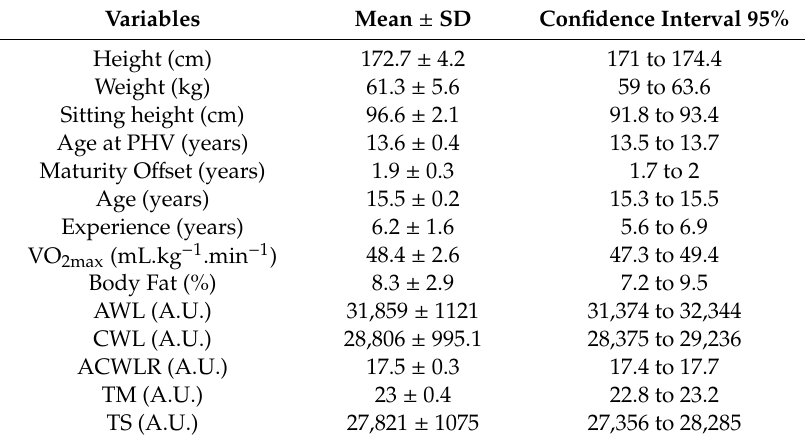
Table 1. Descriptive characteristics of 23 soccer player